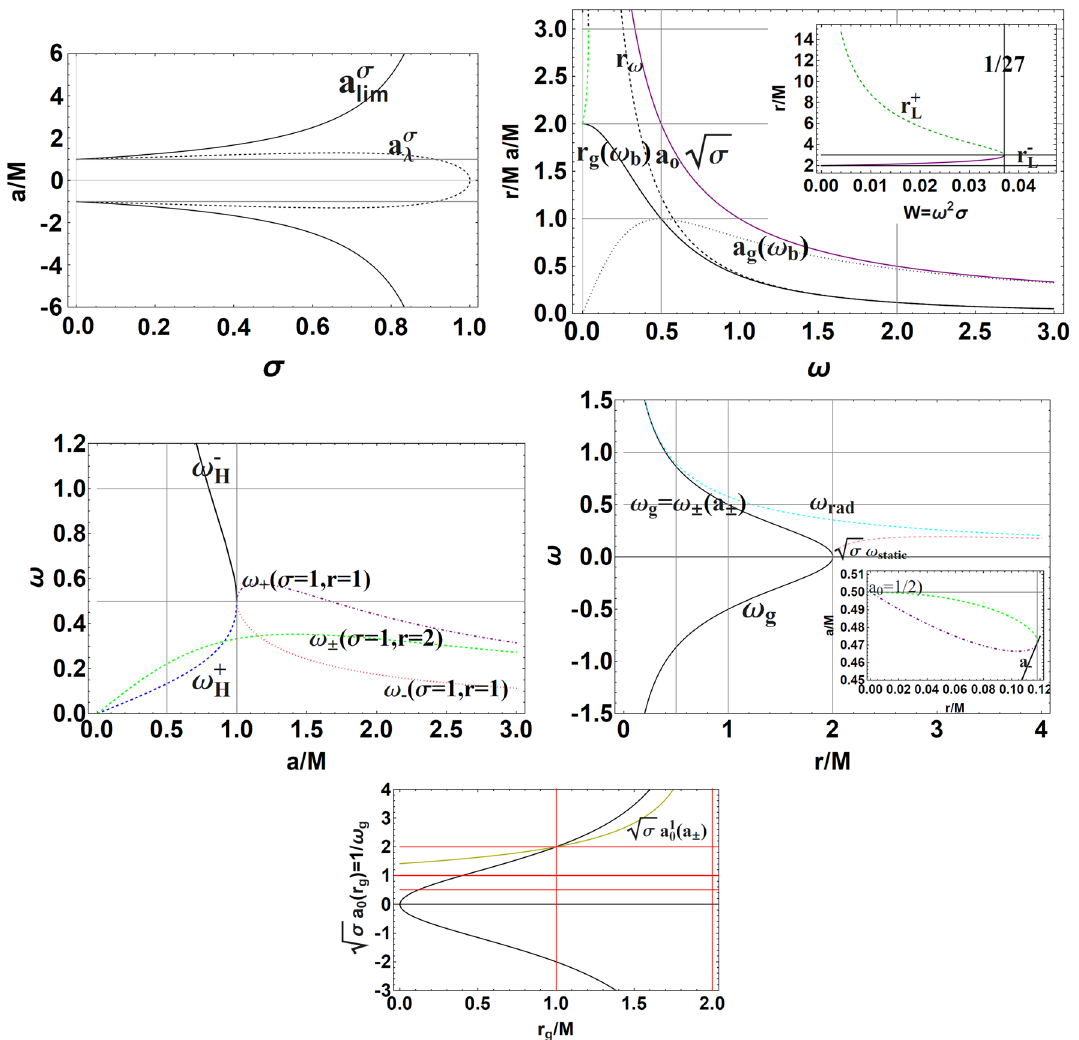
√ σ and the tangent . Center line-right panel: H